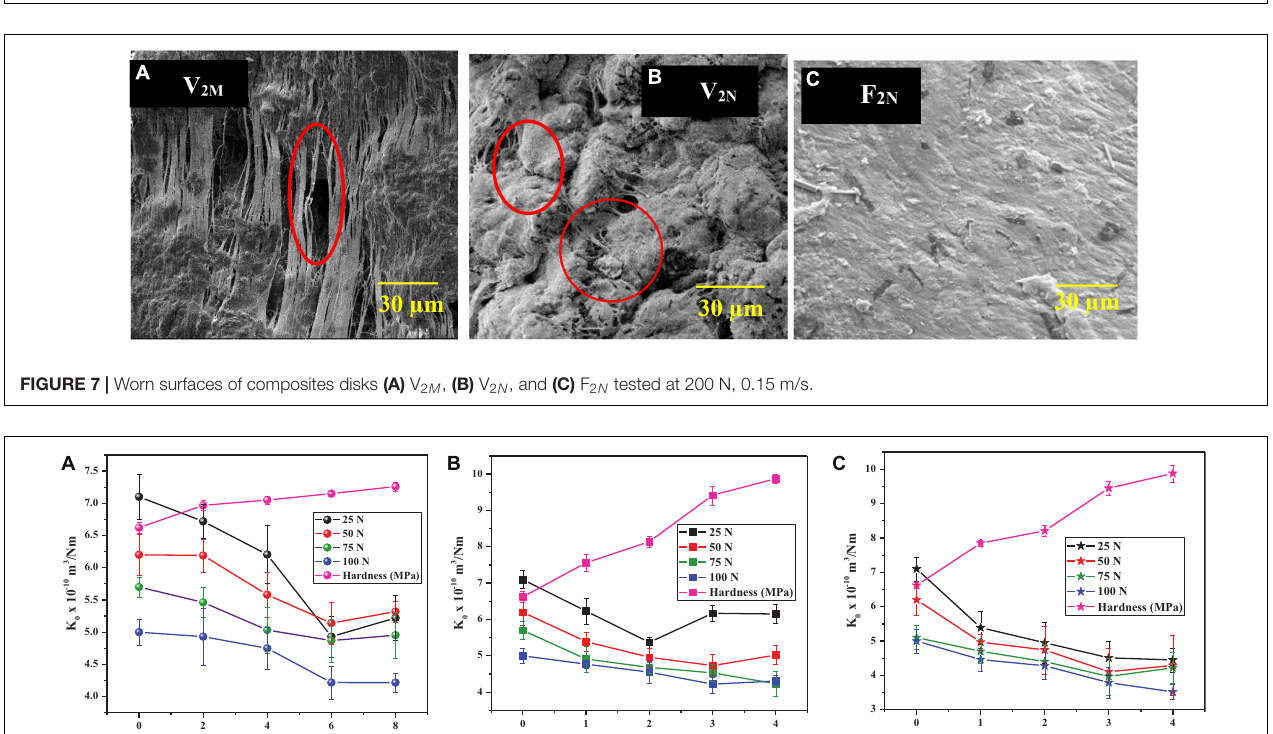
FIGURE 6 | Failed ball (A) against disks of a microcomposite (B,C) at 300 N and (D) disk of UHMWPE at 300 N.